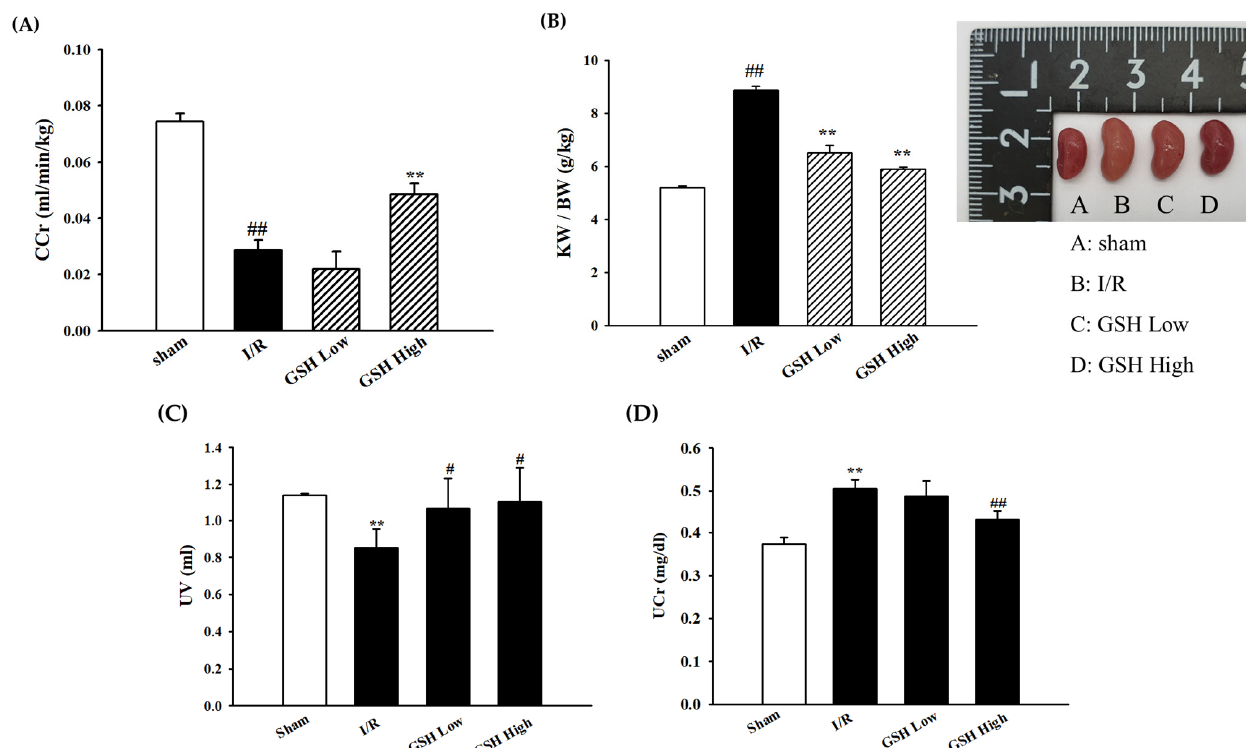
Figure 1. Effect of GSH on creatinine clearance (CCr) ( A ), KW/BW ( B ), UV ( C ), and urine creatinine (UCr) ( D ) in mice. Values are expressed as mean ± S.E. ( n = 9 per group). ## p < 0.01 vs. sham group; * p < 0.05, ** p < 0.01 vs. I/R group.